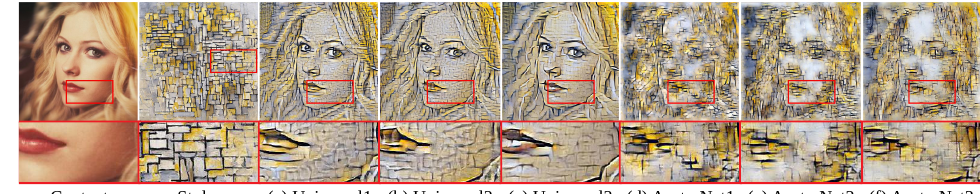
Figure 5. Comparison of the output images of pruned style transfer network using the proposed pruning method and the existing pruning method [12]: the existing method used the same number of parameters as the proposed method. ( a ) Universal [3] with end-to-end learning scheme [41], ( b ) Universal with our pruning, ( c ) Universal with the previous pruning [12], ( d ) AvatarNet [4] with end-to-end learning scheme [41], ( e ) AvatarNet with our pruning, ( f ) AvatarNet with the previous pruning [12].